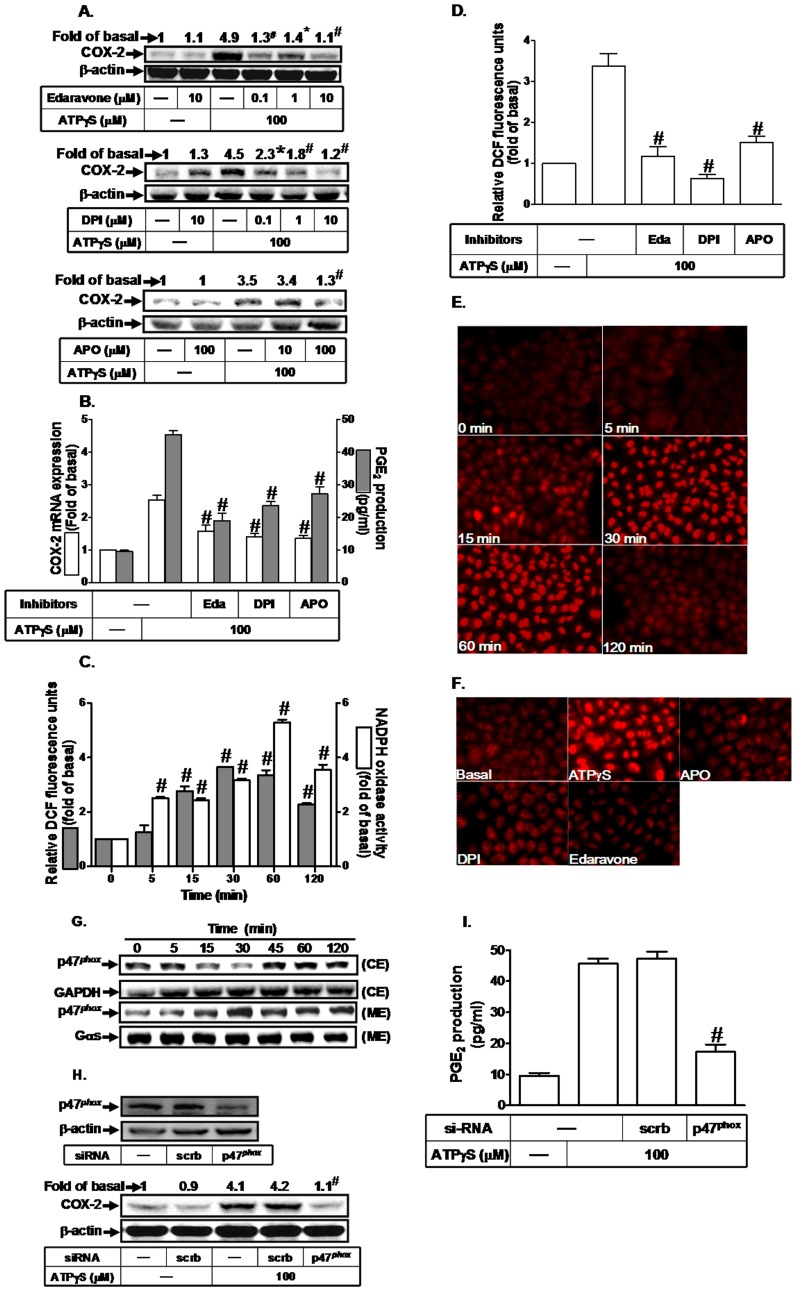
ATPγS induces NADPH oxidase-dependent COX-2 expression in A549 cells.Cells were pretreated with Edaravone, DPI, or APO for 1 h, and then incubated with ATPγS for (A) 6 h or (B) 2 h. The levels of COX-2 (A) protein and (B) mRNA were analyzed by western blot and real-time PCR, respectively. (A) The media were collected and analyzed for PGE2 release. Cells were labeled with DCF-DA (10 µM), and then incubated with ATPγS (100 µM) for (C) the indicated time intervals or (D) pretreated with Edaravone (10 µM), DPI (10 µM), or APO (100 µM) for 1 h, and then stimulated with ATPγS (100 µM) for 1 h. The fluorescence intensity (relative DCF fluorescence) was measured and NADPH oxidase activity was determined. Cells were treated with (E) ATPγS for the indicated time intervals or (F) pretreated with Edaravone (10 µM), DPI (10 µM), or APO (100 µM) for 1 h, and then stimulated with ATPγS (100 µM) for 1 h. After incubation, CellROX™ Deep Red Reagent was added at a final concentration of 5 µM to the cells, and then incubated for 30 min at 37°C. Subsequently, medium was removed and the cells were washed thrice with PBS. The resulting fluorescence was measured using a fluorescence microscope. (G) Cells were incubated with ATPγS (100 µM) for the indicated time intervals. The membrane and cytosolic fractions were prepared and analyzed by western blot using an anti-p47phox antibody. (H, I) Cells were transfected with siRNA of scrambled or p47phox, and then incubated with ATPγS for 6 h. The levels of p47phox and COX-2 expression were analyzed by western blot. The media was collected and analyzed for PGE2 release. Data are expressed as mean±S.E.M. of three independent experiments. *p<0.5; #
p<0.01, as compared with the cells exposed to ATPγS alone (A, B, D), the cells exposed to vehicle alone (C), or the cells transfected with scrambled siRNA and exposed to ATPγS alone (H, I).